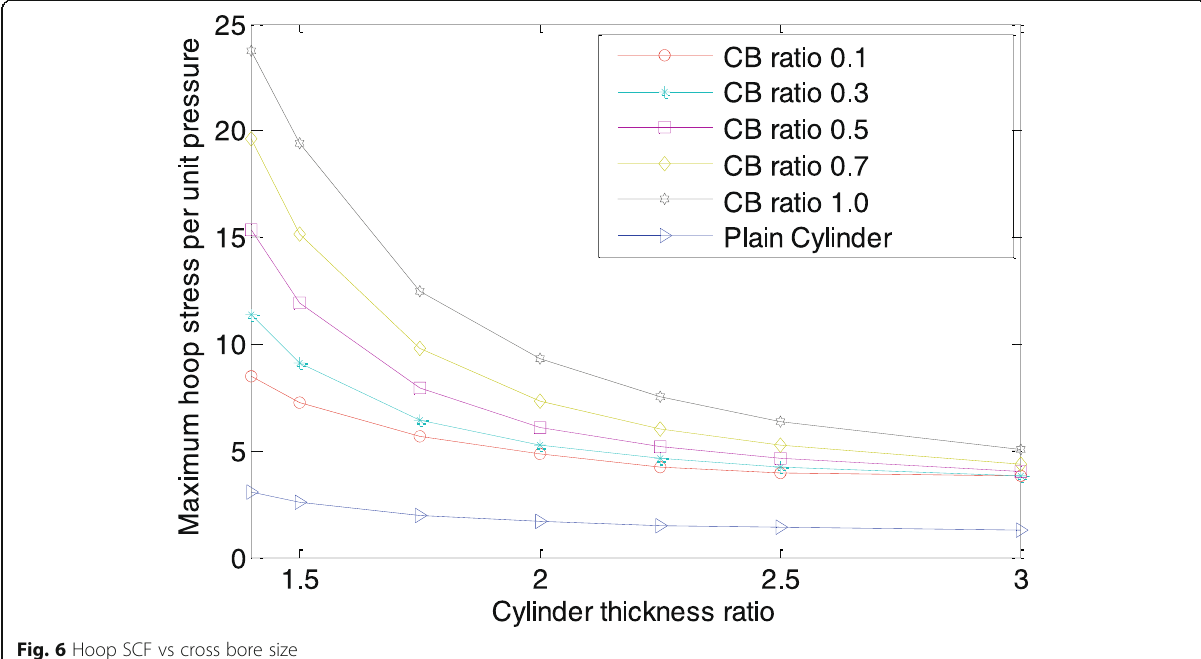
Fig. 6 Hoop SCF vs cross bore size